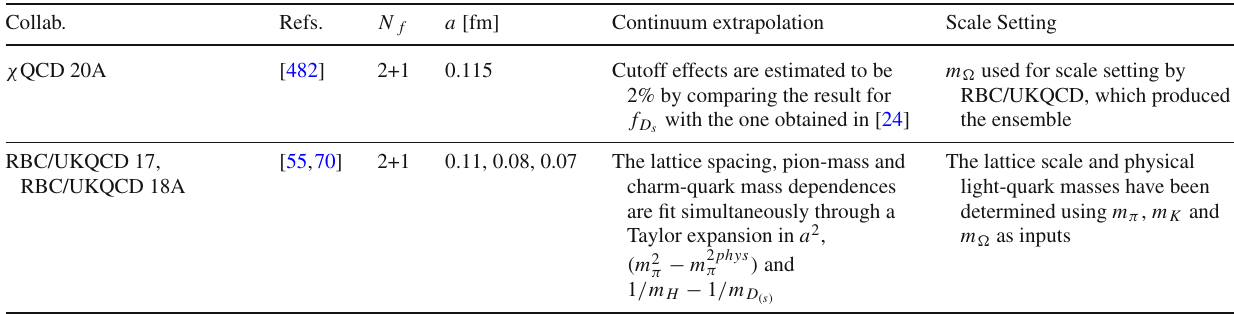
Table 129 Lattice spacings and description of actions used in N f = 2 + 1 determinations of the D - and D s -meson decay constants Collab.